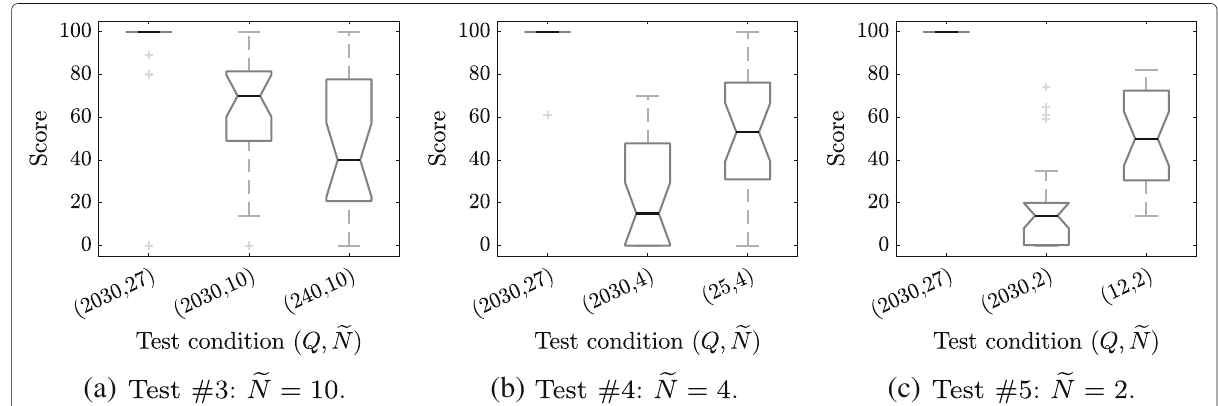
Fig. 8 Box plot of scores showing truncation and sparsity conditions at different SH orders, for loudnessstability evaluation. Each box represents a different ( Q , (cid:11) N ) condition. The box bounds the IQR divided by the median, and Tukey-style whiskers extend to a maximum of 1.5 × IQR beyond the box. The notches refer to a 95% confidence interval. a Test #3: (cid:11) N = 10. b Test #4: (cid:11) N = 4. c Test #5: (cid:11) N =